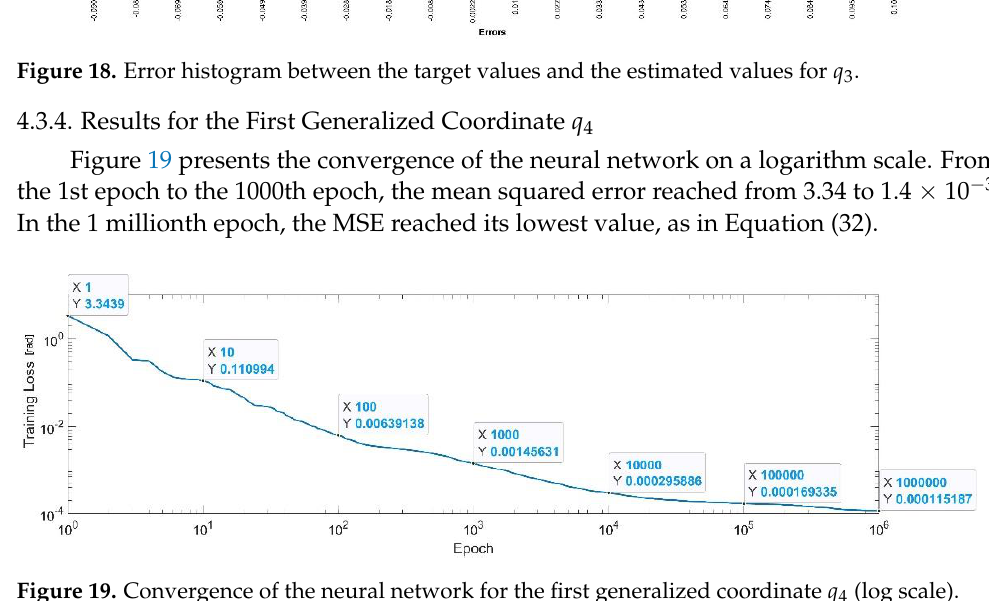
Figure 20. The comparison between the real data (the real value of 𝑞 4 ) and the predicted data (the predicted value of 𝑞 4